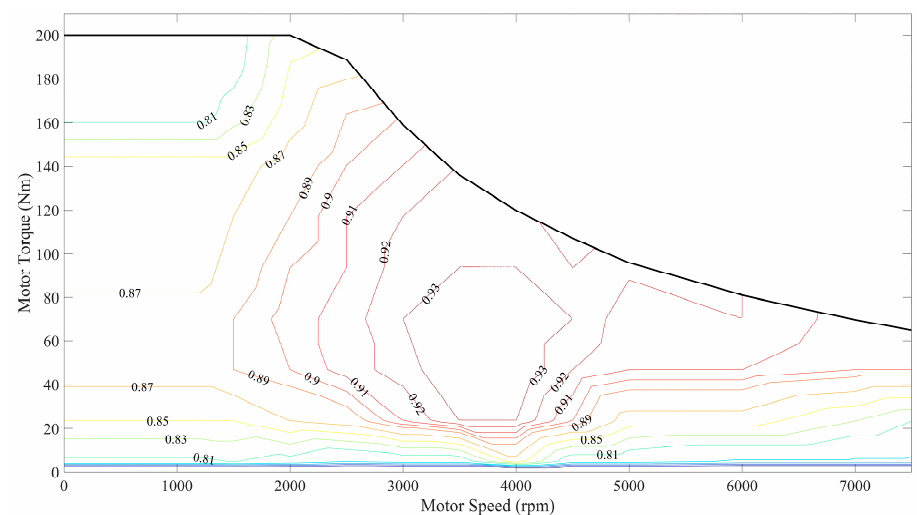
Figure 3. E ffi ciency map of EM_T in